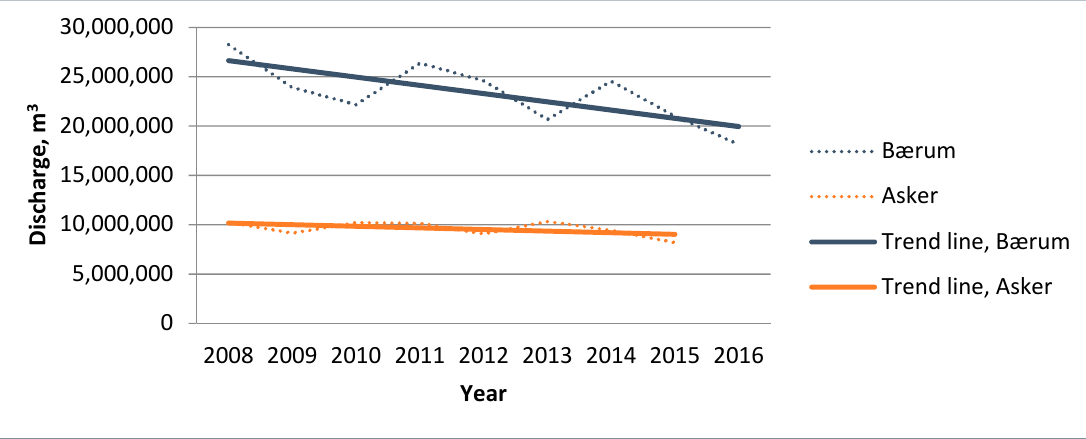
Figure 4. Development of I/I-water in Asker and Bærum municipalities for 2008–2016.